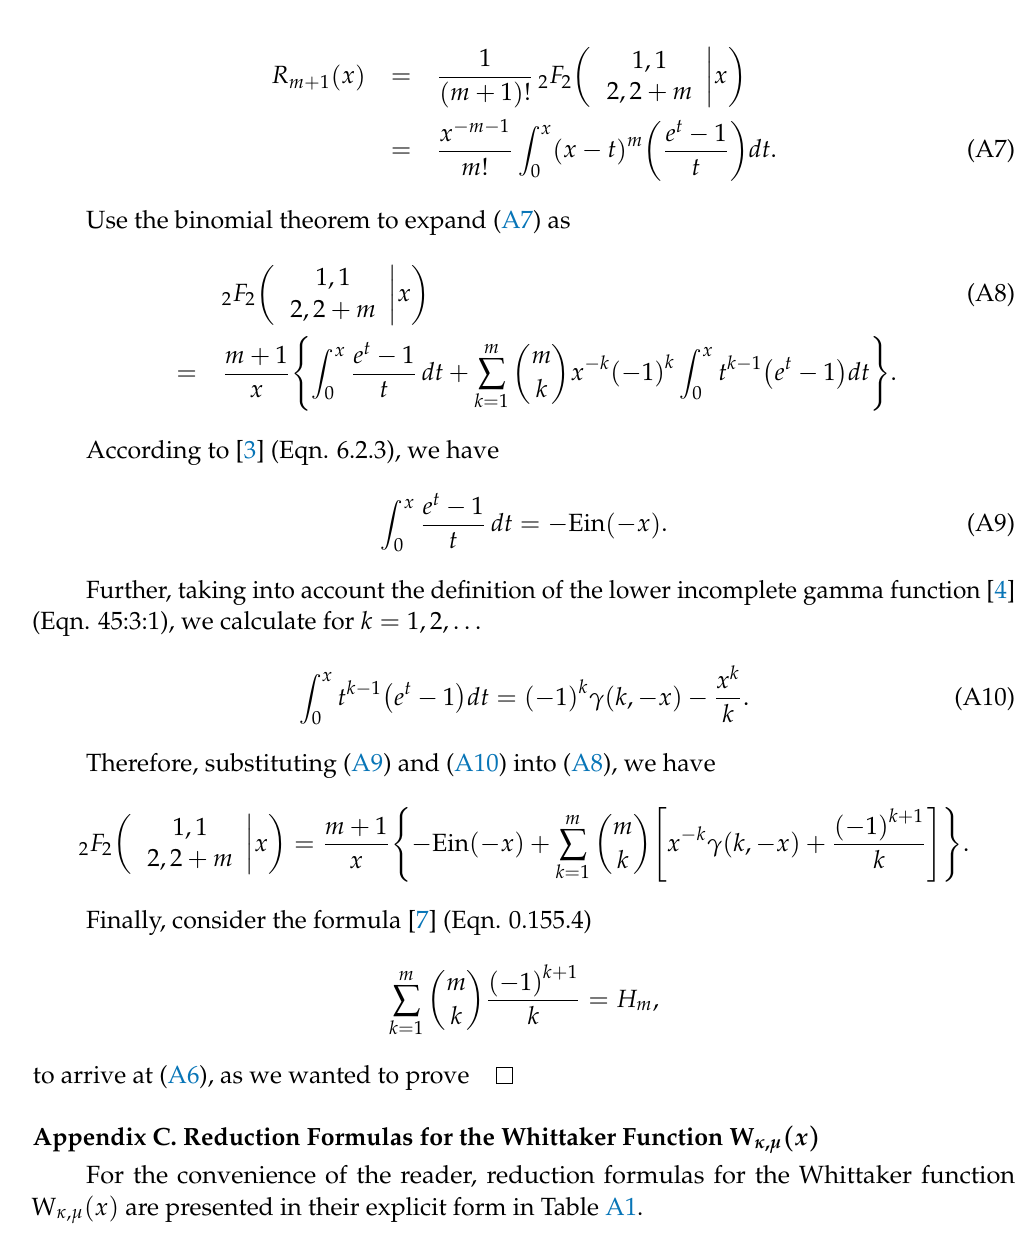
Table A1. Whittaker function W κ , µ ( x ) for particular values of κ and µ